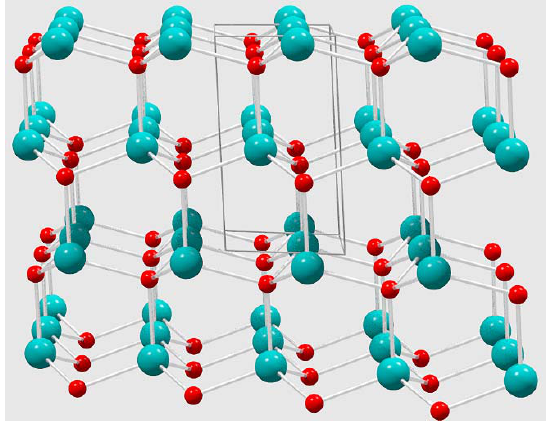
Figure 5. Wurtzite ZnO crystal structure extended view (box indicated unit cell) that highlights tetrahedral geometry around both Zn and O atoms in the solid-state hexagonal lattice.